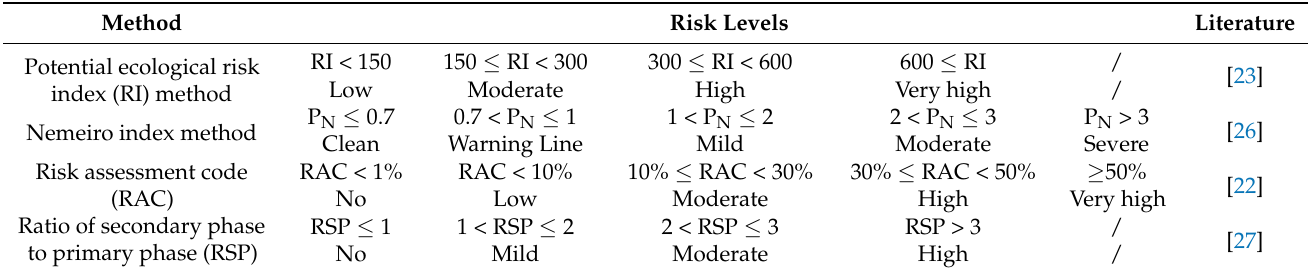
Table 2. Evaluation criteria of the four methods for the evaluation of heavy metals in the